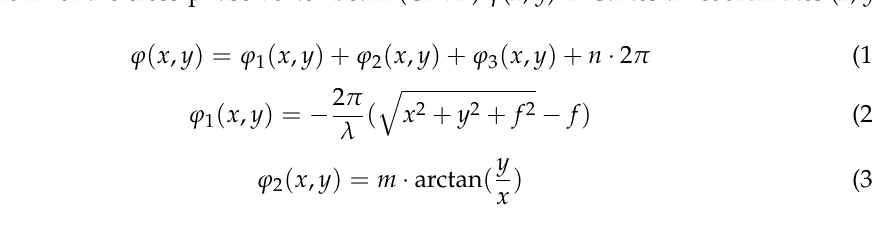
Figure 2. Phase mask generation process. ( a ) Focused lens phase. ( b ) Optical vortex phase. ( c ) LOCP phase. ( d ) The generated LOCP phase mask. ( e ) HOCP phase. ( f ) The generated HOCP phase mask.